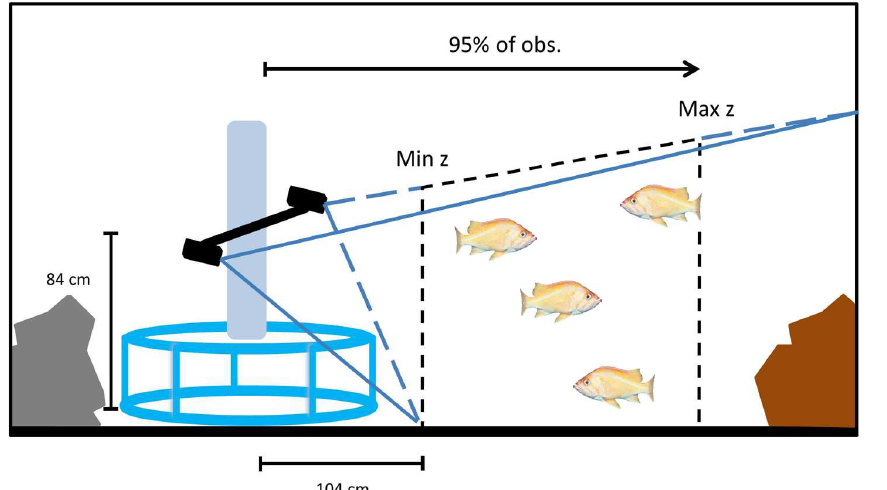
Fig 3. Schematic of area surveyedby rotating stereo-video